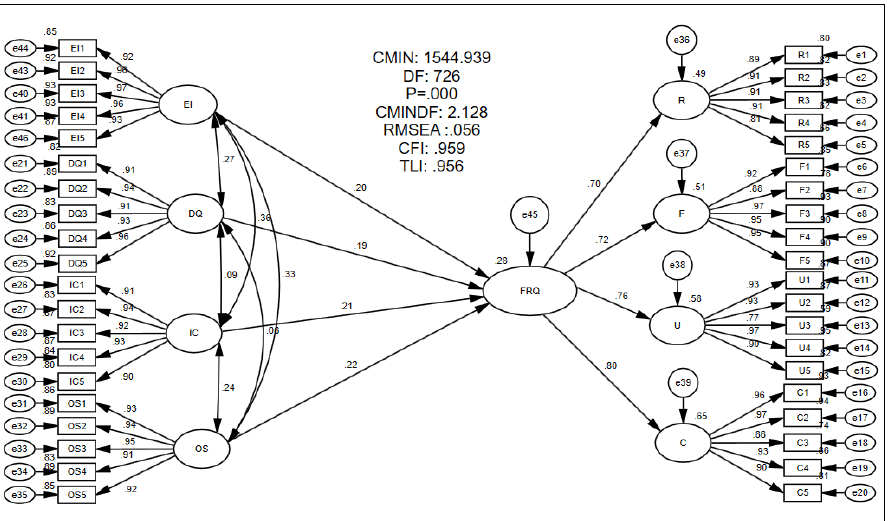
Figure 4. Assessment of structural equation modelling.